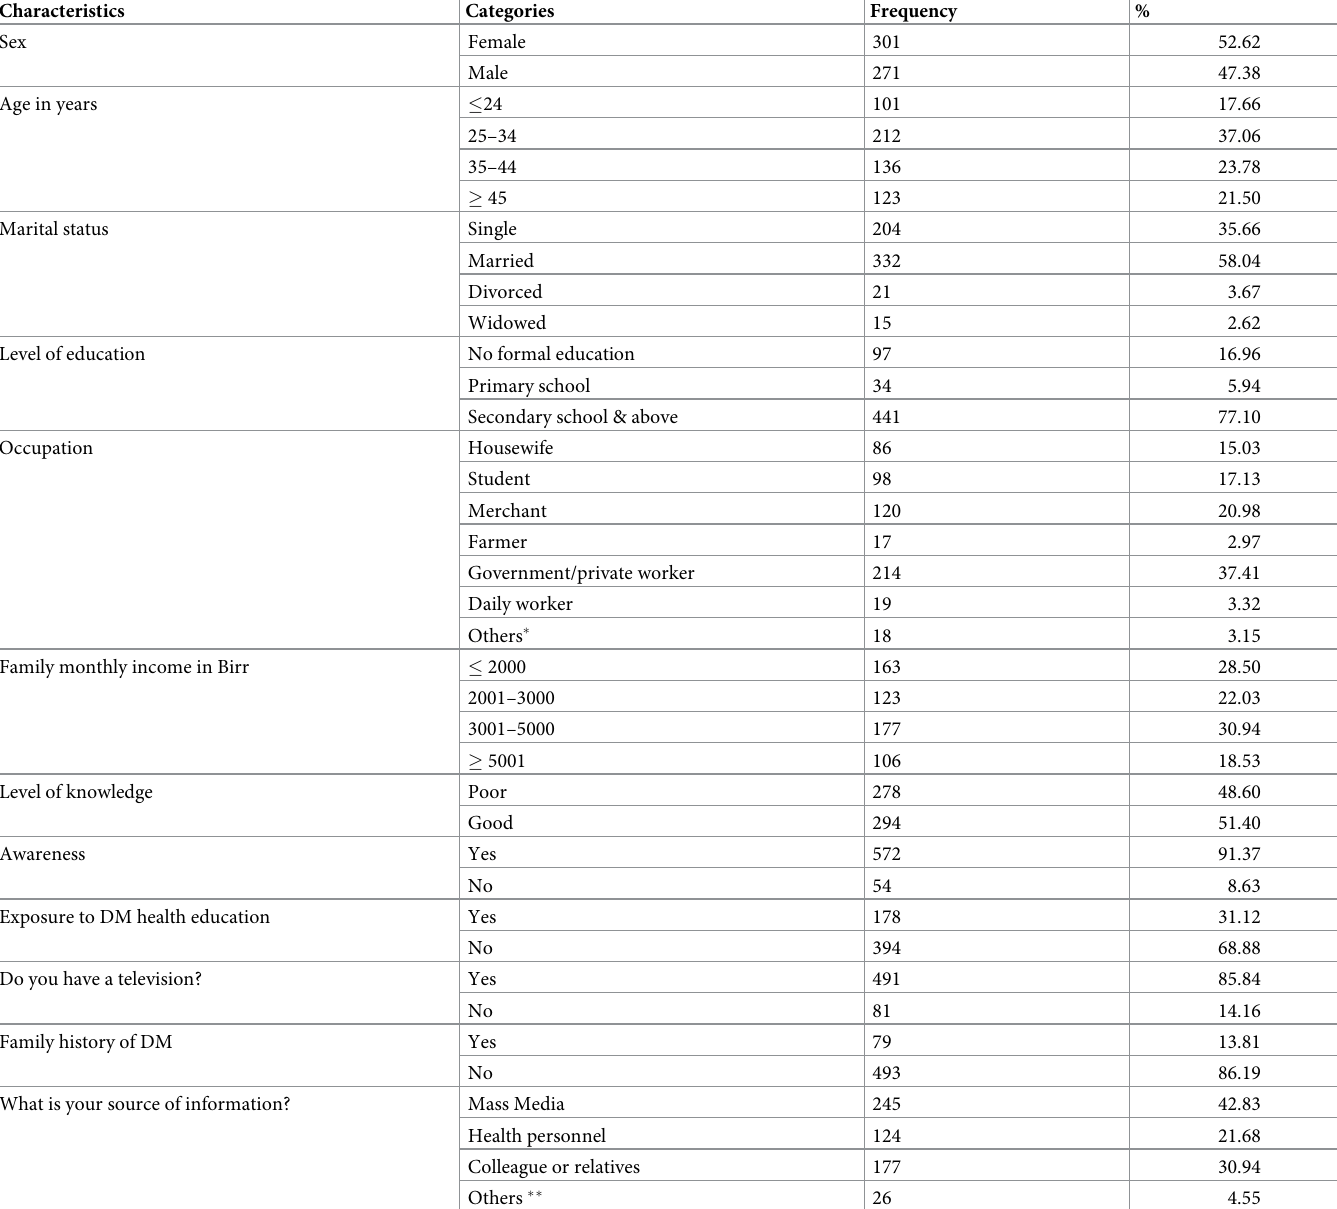
Table 1. Socio-demographic characteristics and source of information of respondents to assess attitude towards DM among adult non-diabetic participants in 2019 (n = 572).